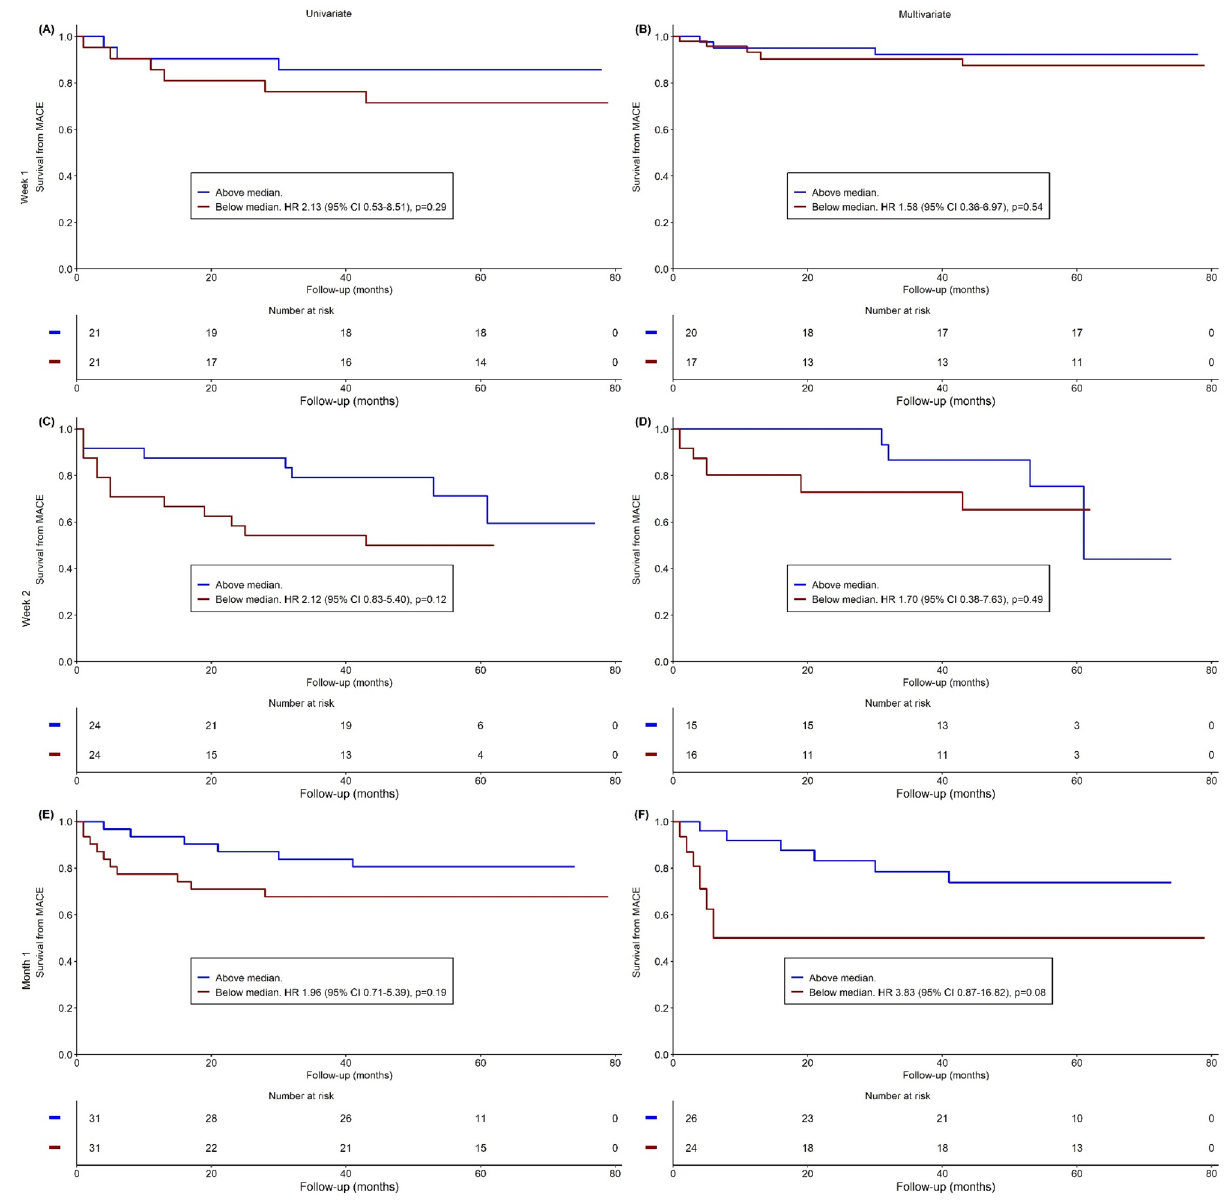
Figure 1. Predictive value of Mon1 for MACE. Univariate (left column) and multivariate (right column) s urvival analyses from MACE in Mon1 according the changes in blood counts of monocyte subsets at one week ( A , B ), two weeks ( C , D ), and one month ( E , F ). MACE Major adverse cardiovascular events, HR Hazard ratio, CI Confidence